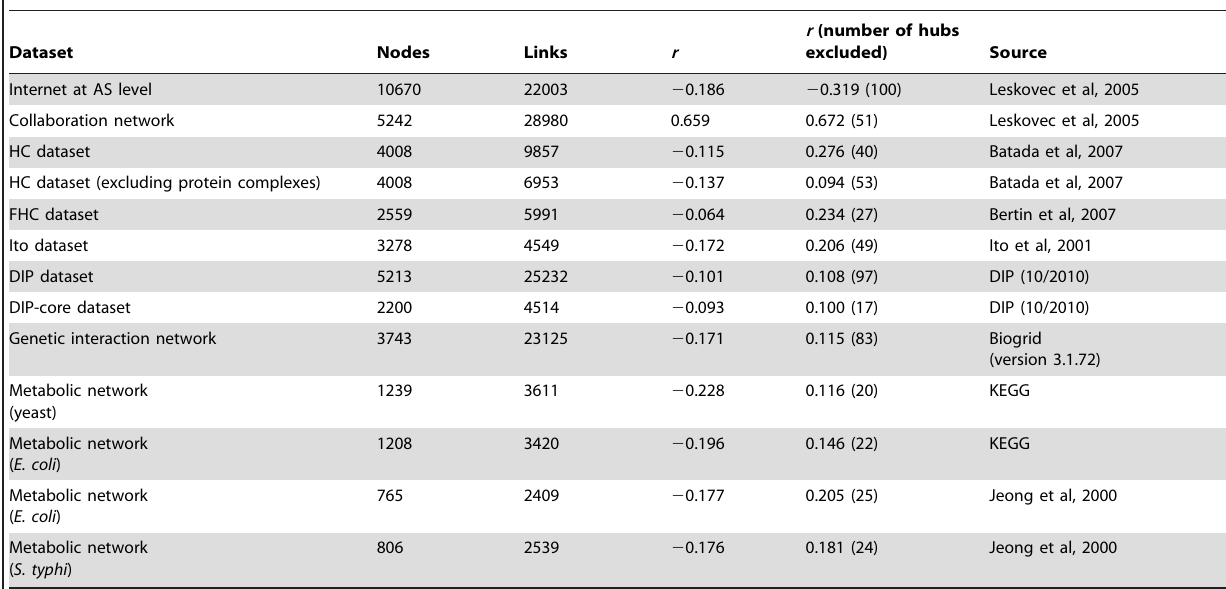
Table 1. Network datasets and their assortative coefficients r